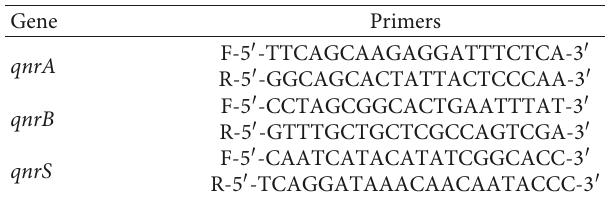
Table 1: Primers used for screening of qnr genes in K. pneumoniae clinical